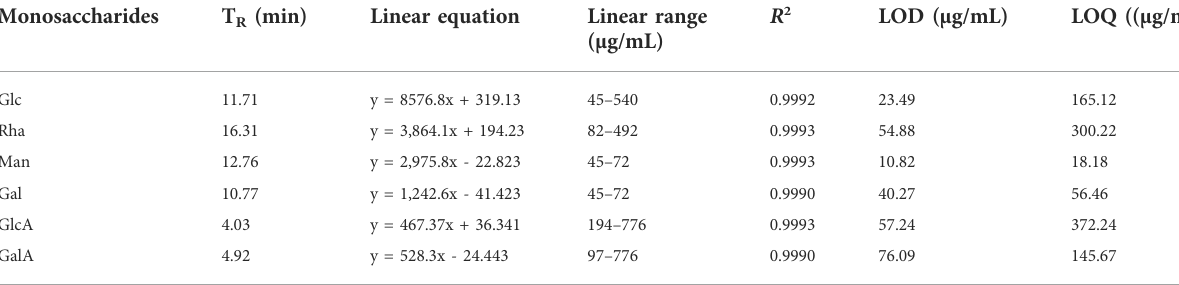
TABLE 1 Linearity, regression line and LOD of the derivatives with the proposed method. Monosaccharides